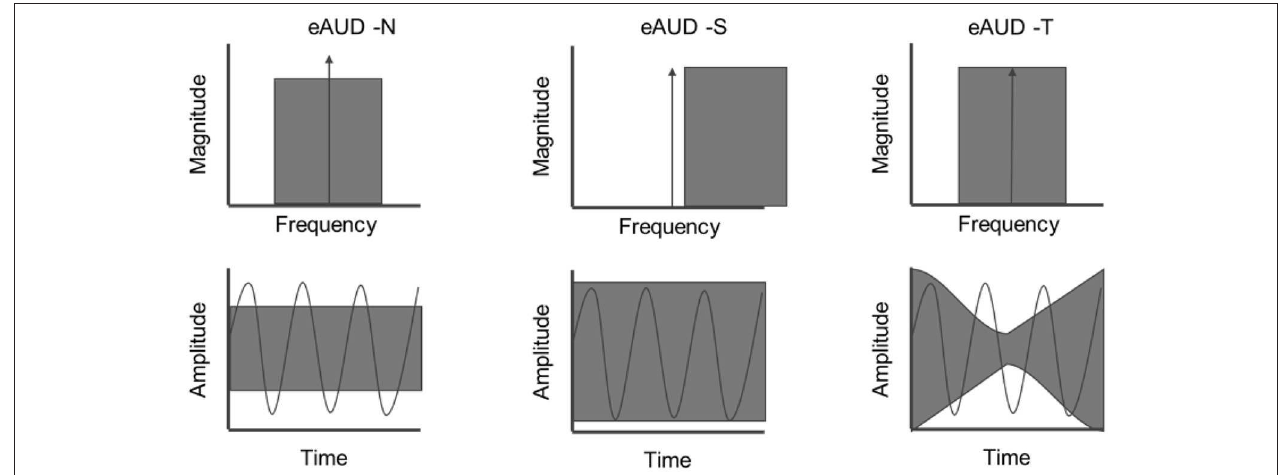
FIGURE 3 | Sketch of the conditions of the spectro-temporal resolution measures of the extended audiometry in noise (eAUD). The top panel shows the spectrum of the noise and target pure-tone (delta), the bottom panel shows both signals in the time domain. Left panel: Tone in noise condition (eAUD-N). Middle panel: Spectral condition (eAUD-S). Right panel: Temporal condition